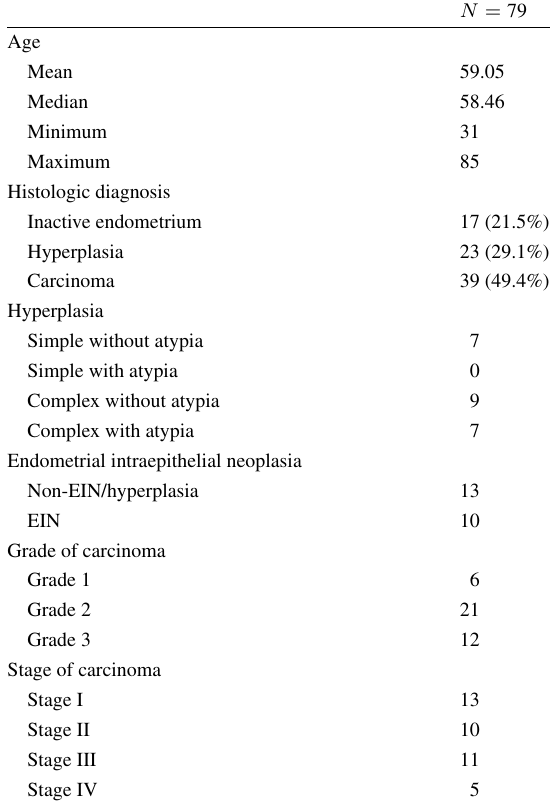
Patient demographics and main pathological